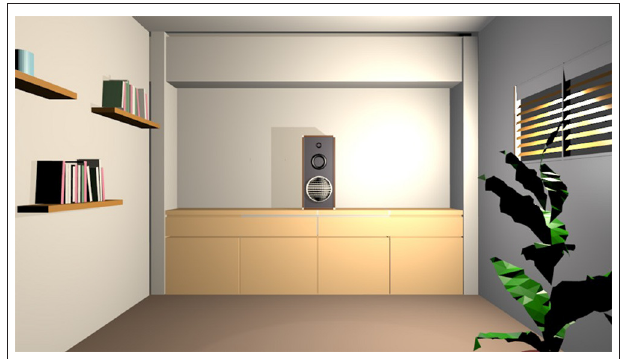
FIGURE 1 | Visual scene of the Auditory Visual Approach/Avoidance by the Self Task